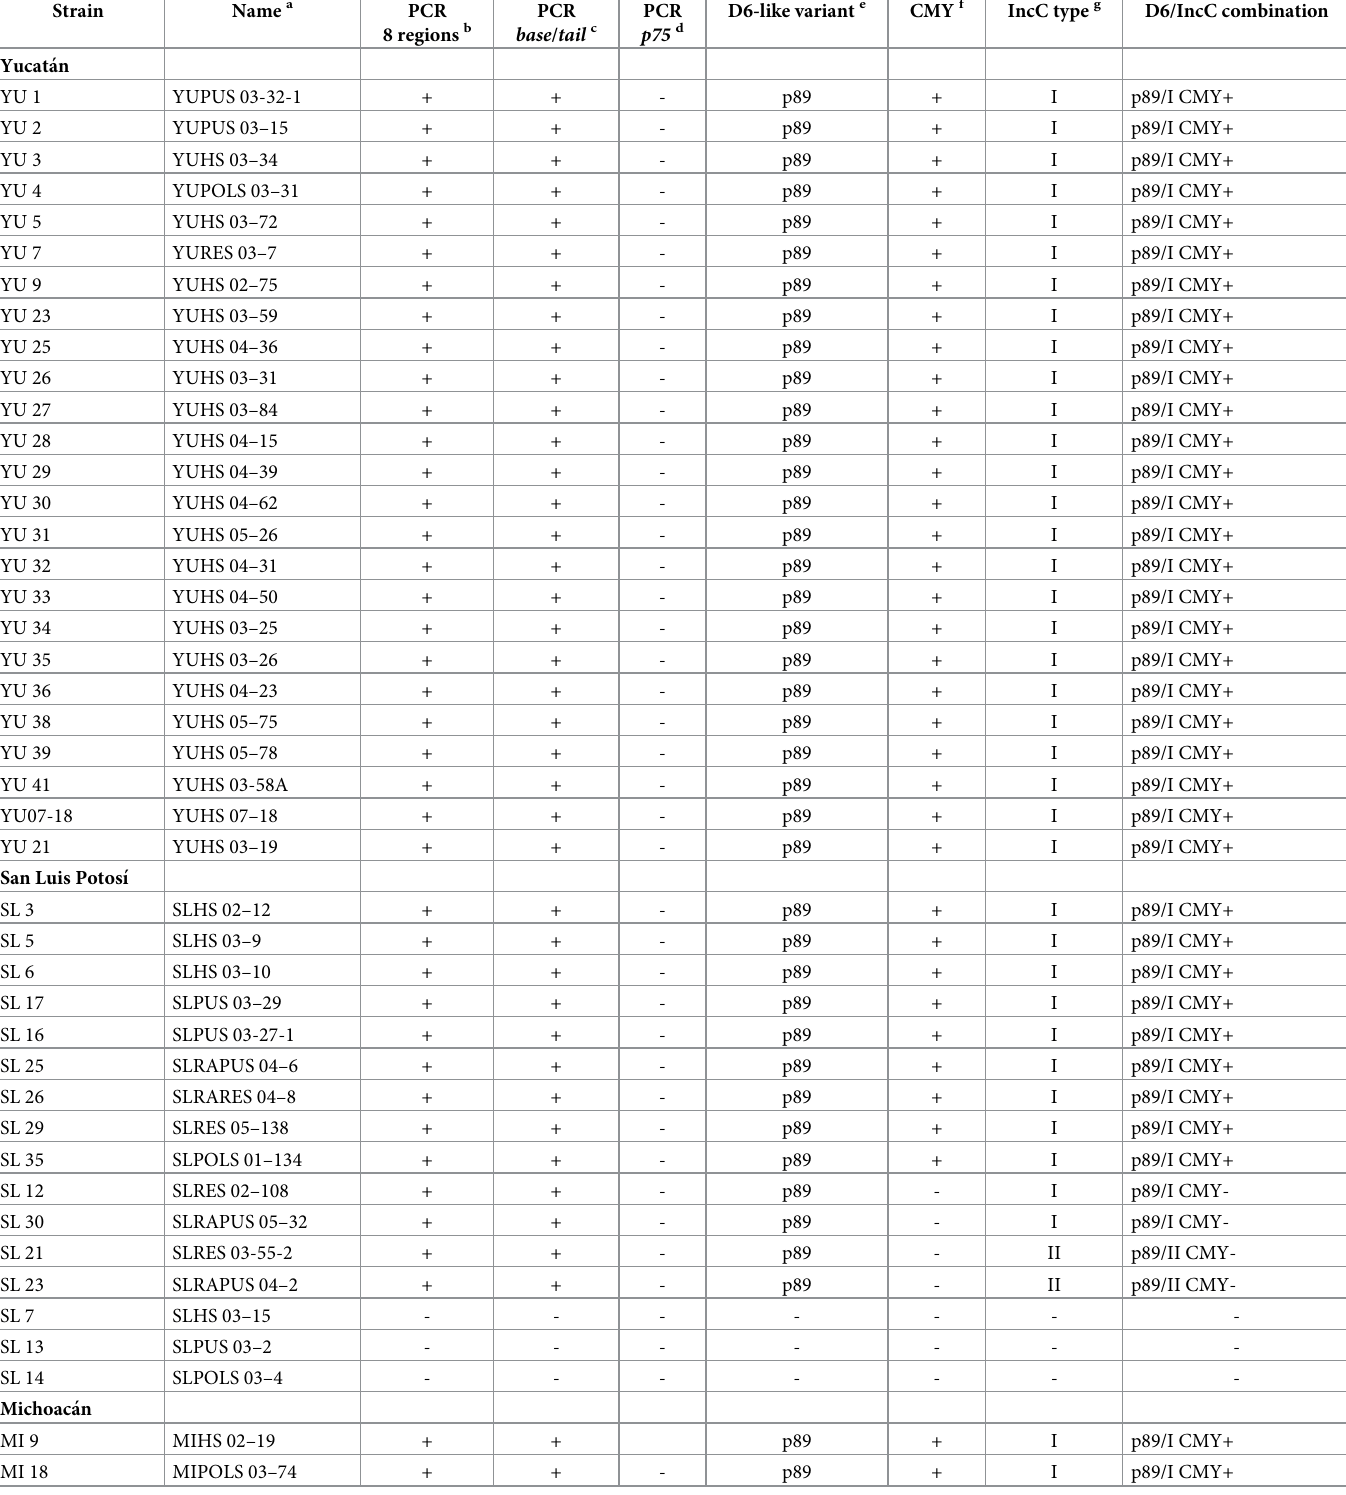
Table 1. Strains of Salmonella Typhimurium ST213 from four geographic regions in Mexico analyzed in this study.